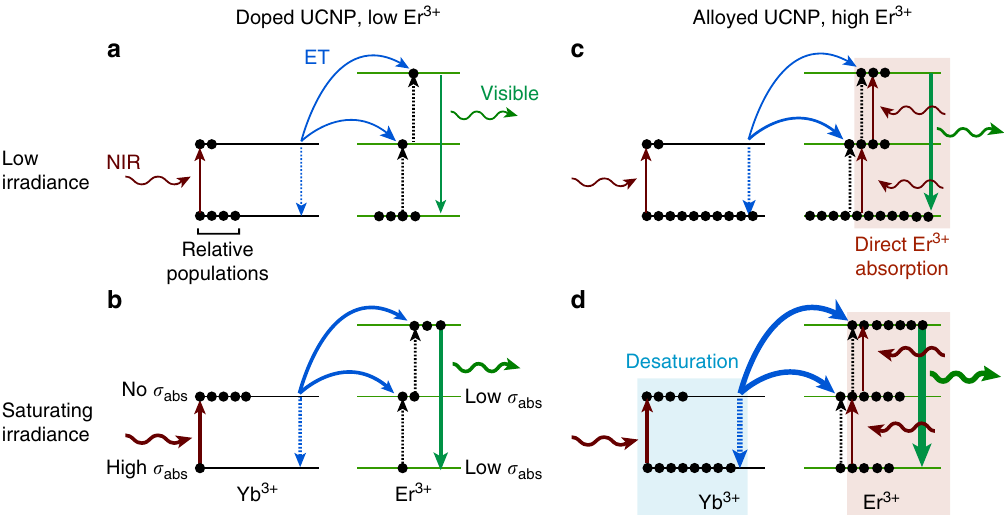
Fig. 5 Mechanisms of enhanced aUCNP absorption. Simpli fi ed energy diagrams of doped ( a , b ) and alloyed ( c , d ) UCNPs at low ( a , c ) and high ( b , d ) irradiances. Energy transfer (ET) is denoted by blue arrows, absorption/emission by colored arrows, and arrow thickness re fl ects ET rates. At higher Er 3 + content, Er 3 + enhances aUCNP absorbance at 980 nm ( σ abs ) indirectly through desaturation of the Yb 3 + excited state above saturating laser intensities, and through direct absorption at both low and high laser intensities. Mechanistic pathways determined by kinetic simulations as in Supplementary Methods